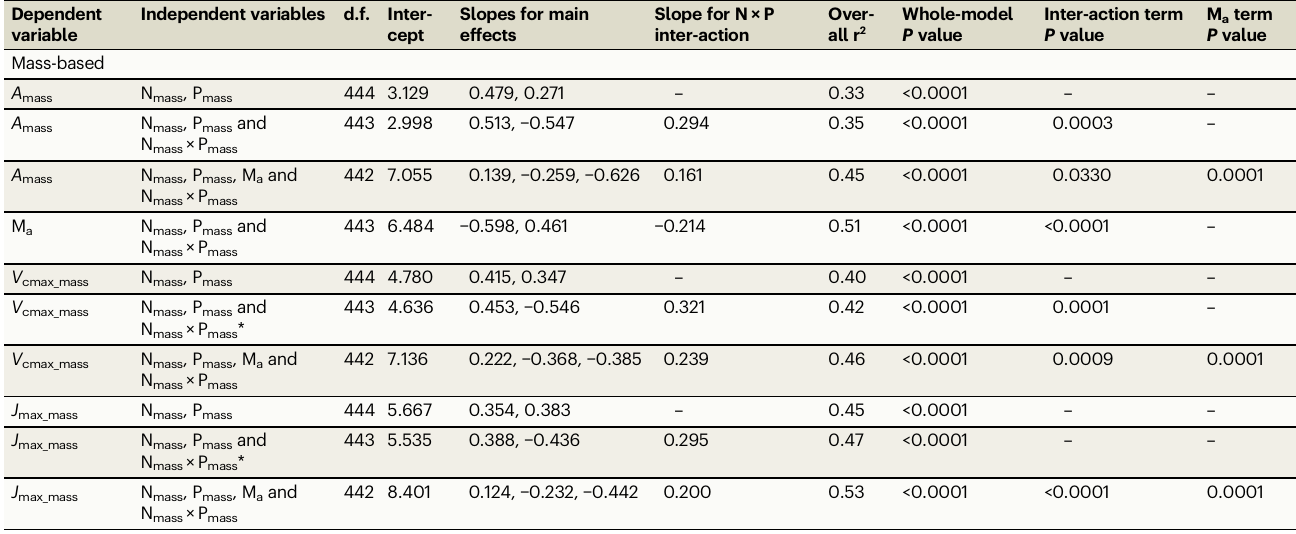
d.f. indicatesthedenominatordegrees offreedom. Regressions showing photosynthesisandmass-basedbiochemical parameters( A mass , V cmax_mass , J max_mass ) and leaf mass per area (M a ) versus leaf N mass andP mass , includingtheir interaction (N mass ×P mass ).Slopesformaineffectsareorderedaccordingtothelistofindependentvariables.TheN mass ×P mass interactionswerepositiveinallcasesexceptforM a .Alltestsforinteractionand additivetermsweredoneusing F -tests.Allvariablesarenatural-logarithmtransformed,andthemodelsfor V cmax_mass and J max_mass withN mass andP mass areillustratedinSupplementaryFig.8.The recommended model forTBMs isindicated